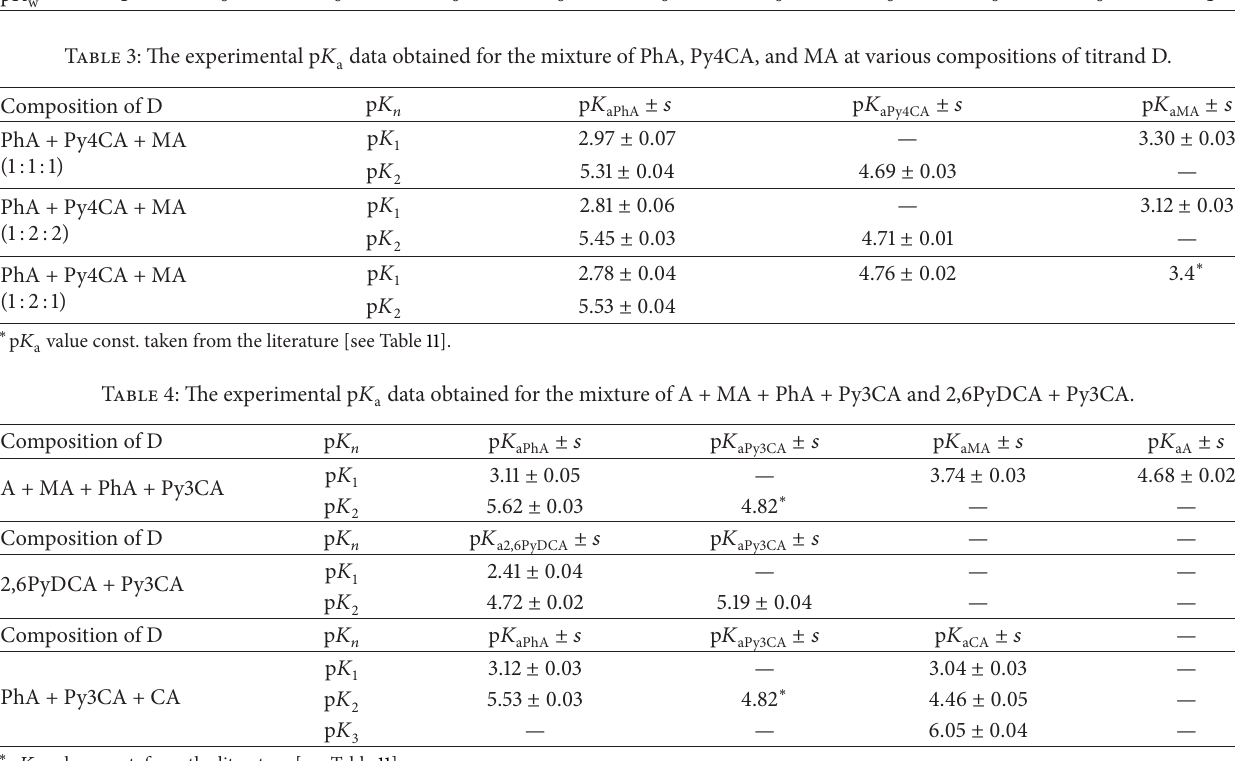
∗ p 𝐾 a value const. from the literature [see Table